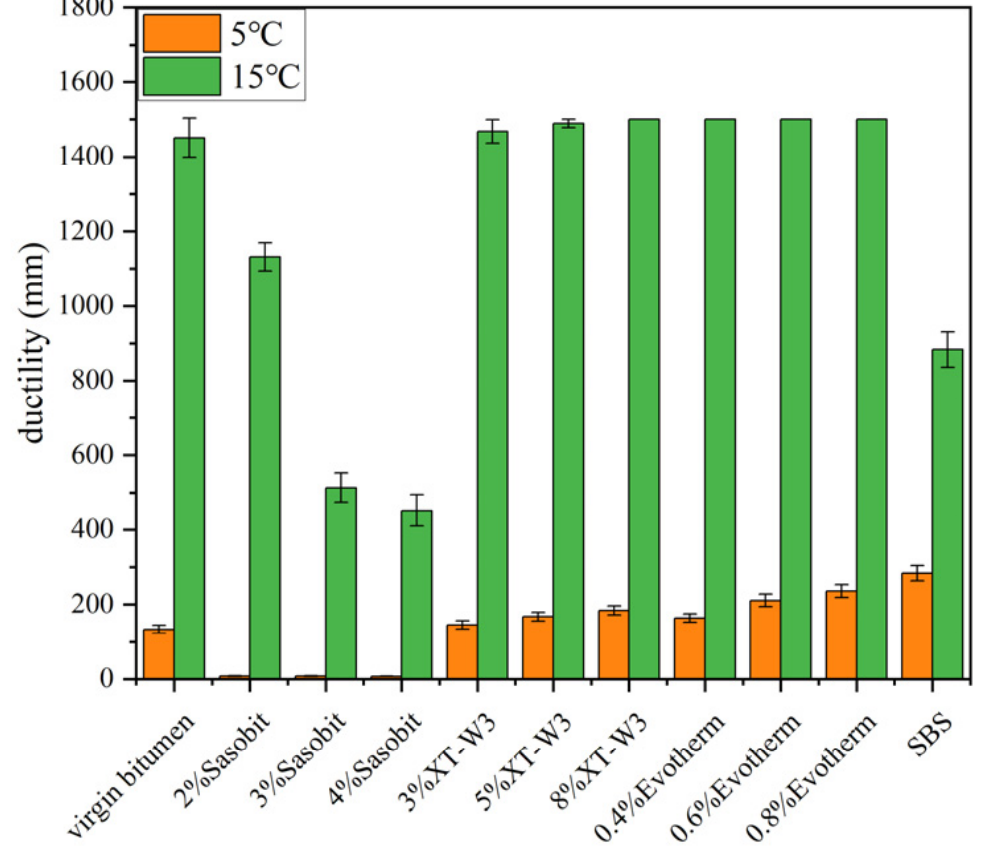
Figure 3. Ductility test results.